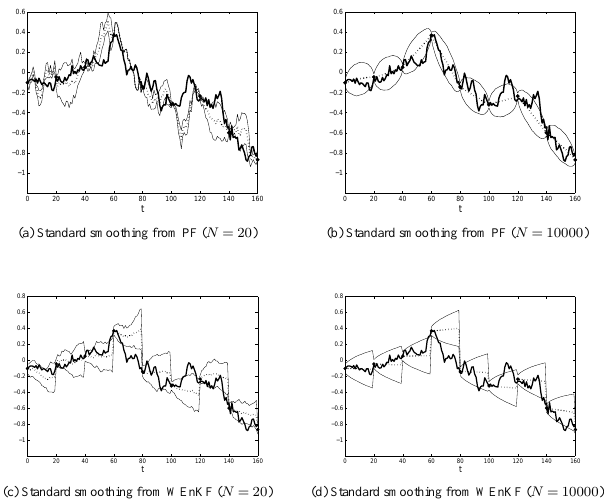
Figure 3. Standard smoothing from PF and WEnKF results. Thick Fig. 3: Standard smoothing from PF and WEnKF results. Thick line: hidden diffusion; Dots: partial observa- line: hidden diffusion; dots: partial observations; dotted line: esti- tions; Dotted line: estimated filtering mean. mated filtering mean.